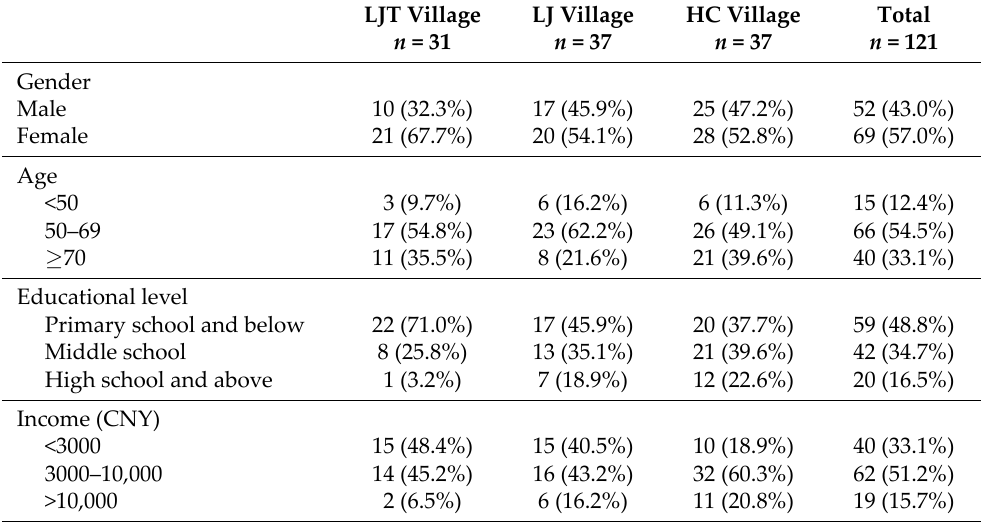
Table 2. Demographic characteristics of